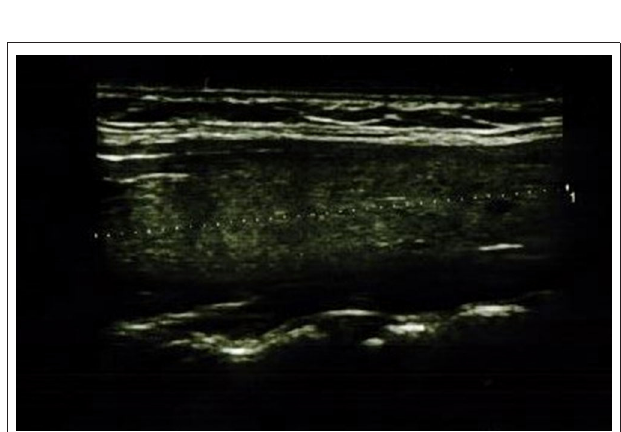
FIGURE 3 | Longitudinal image of thyroid gland with significantly decreased parenchymal echo pattern.